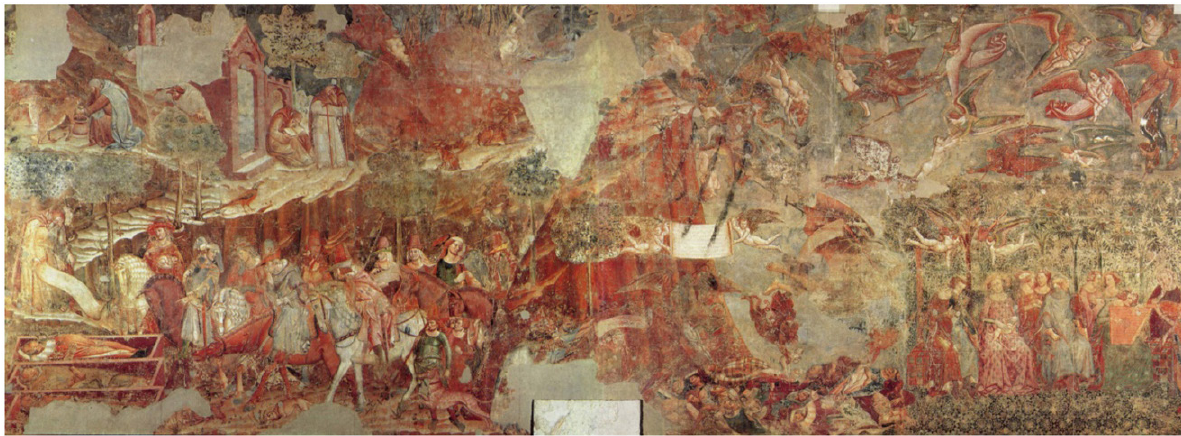
Figure 19. Buanamico Buffalmacco, Il Trionfo della Morte (ca 1330). Le Corbusier used a fragment of the fight between angels and devils in an overcrowded sky in his paper “Urbanisme et aéronautique” (1947), with the text “Nous avons connu déjà le ciel de Paris rempli du vrombissement des quadrimoteurs. Sur mon toit-jardin, quand l’un d’eux passait, il fallait cesser de